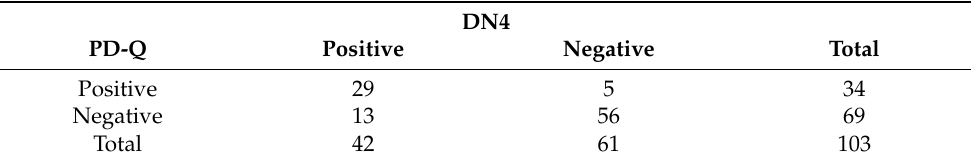
Table 3. The frequency of NP component determined by the DN4 and PD-Q. DN4 PD-Q Positive Negative Total Positive 29 5 34 Negative 13 56 69 Total 42 61